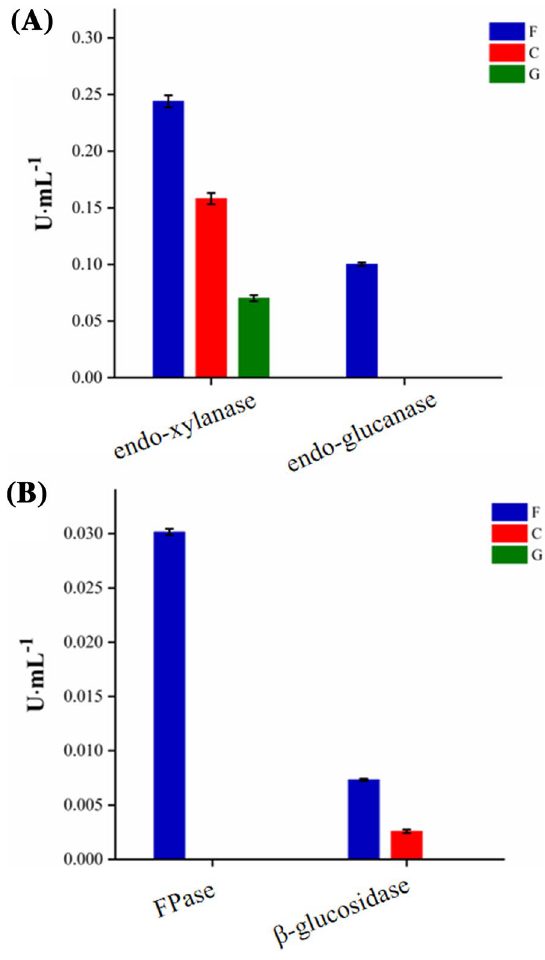
Fig. 6 Enzyme activities measured under different carbon source conditions. A : Endo-xylanase activity and endo-glucanase activity in fermentation broth under different carbon source conditions. B : FPase activity and β-glucosidase activity in fermentation broth under different carbon source conditions. (F/C/G: fermentation supernatant using filter paper, cellobiose and glucose as the sole carbon source,